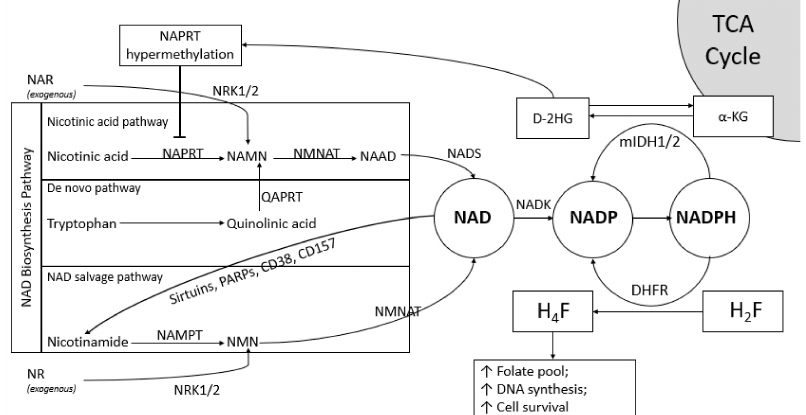
Figure1. Theassociationbetween IDH1 / 2 mutationandNADProductioninCancer. MutantIDH1 /